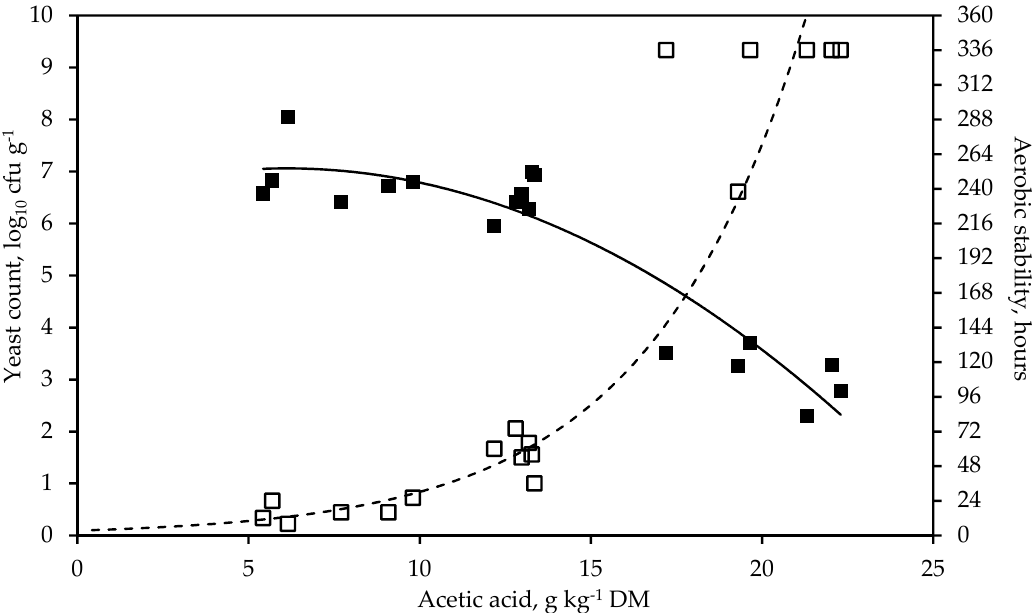
Figure 2. Relationship between the concentration of acetic acid and the yeast count (solid line, y = 6.39 + 0.221x – 0.018x 2 , R 2 = 0.86, RMSE = 0.67, p < 0.001, n = 18) and the aerobic stability (dashed line, y = 3.37xe 0.219x , R 2 = 0.91, RMSE = 0.38, p < 0.001, n = 18), respectively, in whole-crop rye silage treated with different additives and stored for 53 days.